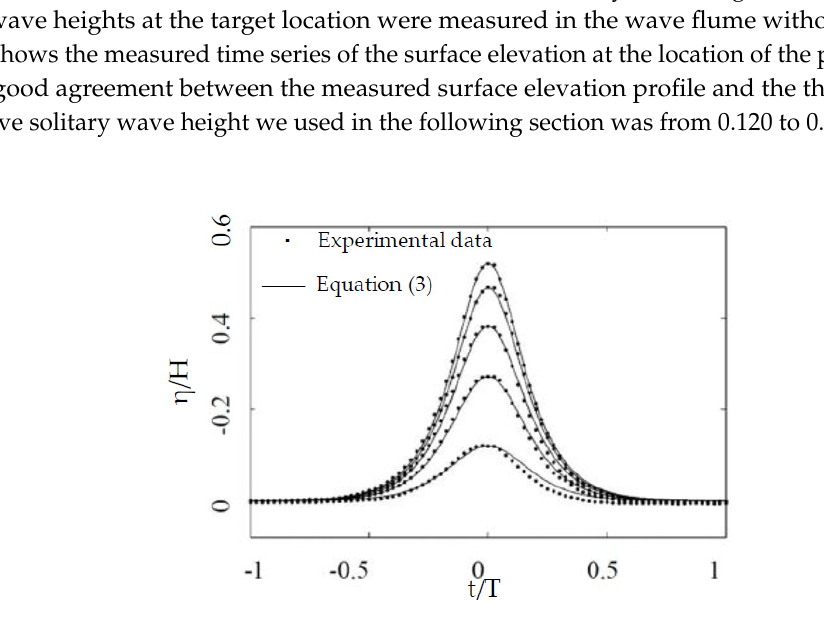
Figure 4. Time series of the surface elevation at the probe WG1 with different input solitary wave heights. Table 3. Details of the test cases of solitary wave conditions. Case 1 (Flat vs.